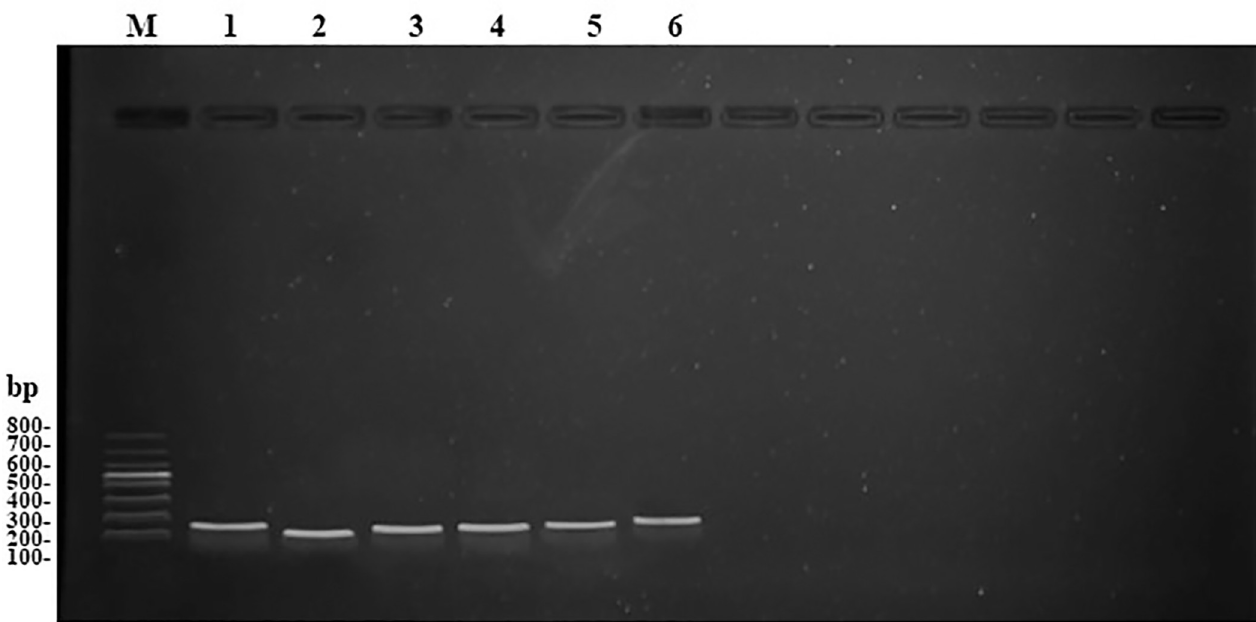
Fig 1. Gel electrophoresis analysis of PCR amplification for each target and reference gene. M, 100 bp DNA Ladder (Takara Bio INC, Beijing, China); 1–6, Actin , 18S , CYP6CY3 , CYP6-1 , E4 and VPS11 .